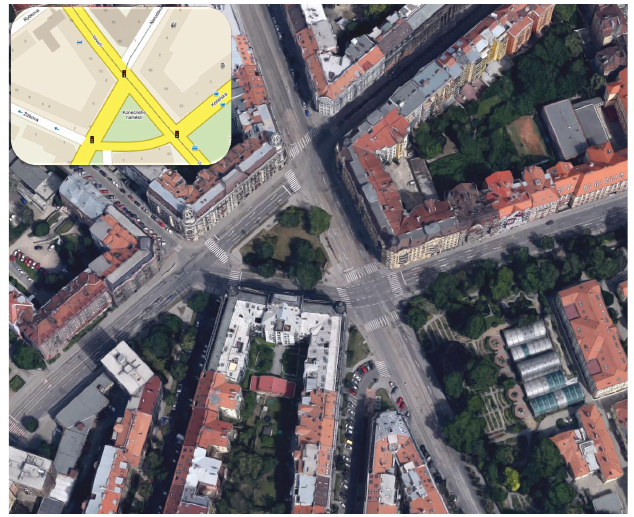
Figure 7. Second example: map view of the real traffic scenario, Brno, Czech Republic (Location: Konecneho